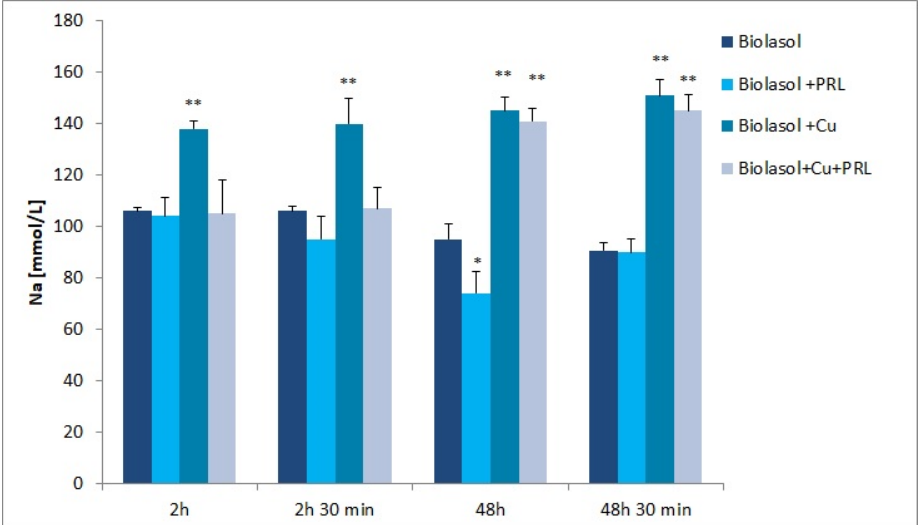
Figure 5. Sodium concentration in perfusate samples taken. The values are expressed as mean ± SEM. Data were analysed by one-way ANOVA and Bonferroni post hoc tests; n = 10; * p < 0.05; ** p < 0.01 compared to the control group (Biolasol).